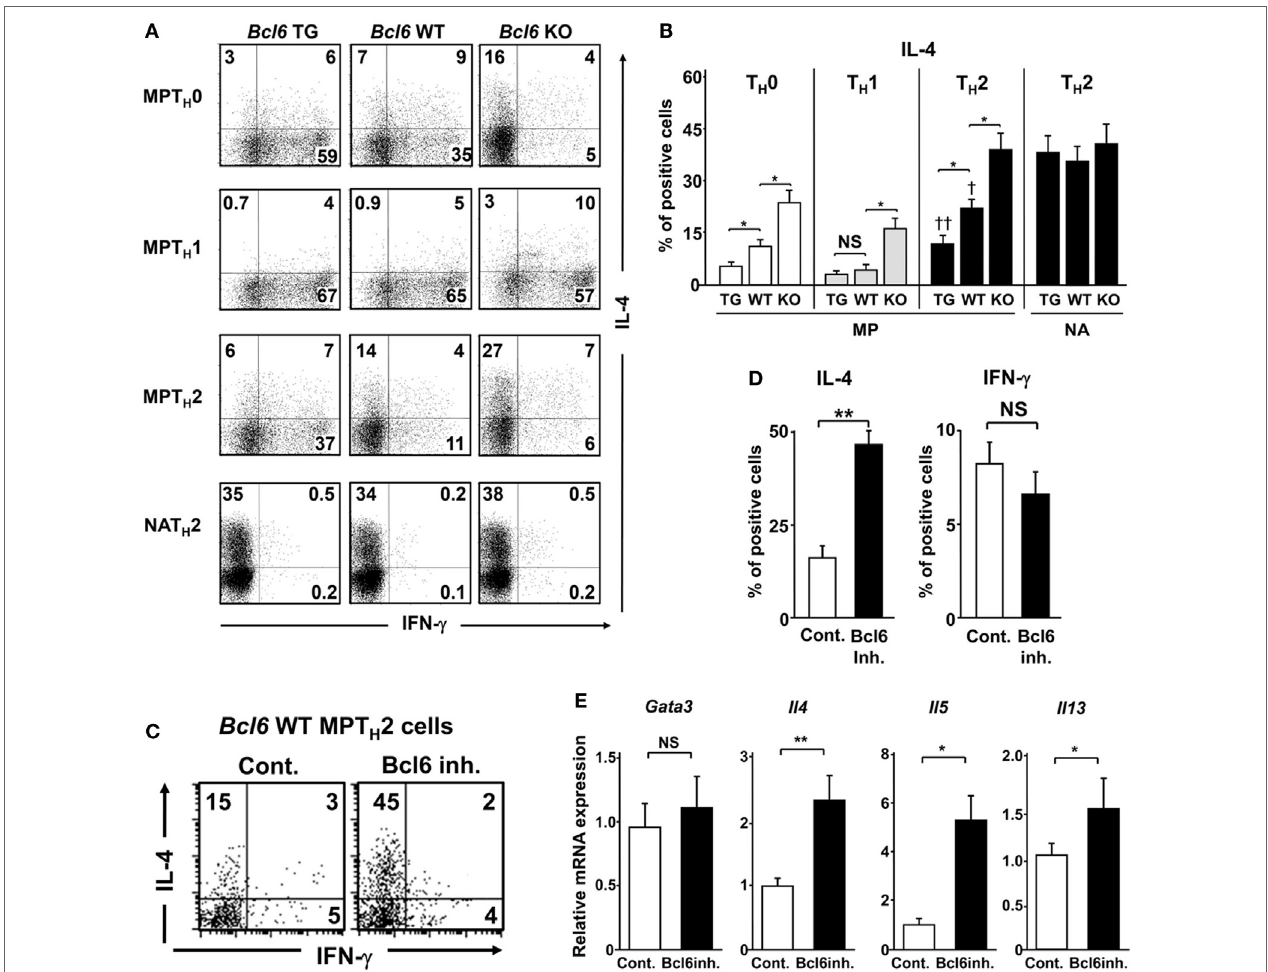
FigUre 2 | Regulatory role of Bcl6 in the differentiation of T H 2 cells. (a – e) KJ1-26 + MPT and NA T cells (CD4 + CD44 l ° w CD62L + ) among splenocytes from Bcl6 -TG, Bcl6 -WT, and Bcl6 -KO DO11.10 mice cultured with ovalbumin peptides and antigen-presenting cells in vitro for 7 days to produce T H 0, T H 1, and T H 2 cells. Cells were restimulated with anti-CD3 monoclonal antibodies. After 8 h, IL-4- and IFN- γ -producing cells among gated KJ1-26 + CD4 + T cells were analyzed by FACS. (c – e) Analysis of cytokine production by Bcl6 -WT MPT H 2 cells treated with a Bcl6 inhibitor (inh.) for 12 h prior to restimulation. (a,c) Numbers in the corners represent percentages among gated T cells. (B,D) Percentage of IL-4 + ( Bcl6 -TG, Bcl6 -WT, and Bcl6 -KO) cells for each T H cell type (B) and IL-4 + and IFN- γ + Bcl6 -WT MPT H 2 cells cultured with or without Bcl6 inhibitor (D) . (e) qRT-PCR analysis of the relative expression of Gata3 , Il4 , Il5 , and Il13 in restimulated Bcl6 -WT MPT H 2 cells treated with or without a Bcl6 inhibitor. Data are presented as the mean ± SEM ( n = 7–8). * P < 0.05, ** P < 0.01, comparison between two groups is indicated; † P < 0.05, compared with Bcl6 -WT. All results are representative of five independent experiments with similar outcomes, excluding (c) , for which four experiments were conducted. Bcl6, B-cell lymphoma 6; Cont., control; FACS, fluorescence-activated cell sorting; KO, knockout; MPT cell, memory phenotype CD4 + T cell; MPT H 2 cell, MPT cell-derived T H 2 cell; NA, naïve; TG, transgenic; WT,